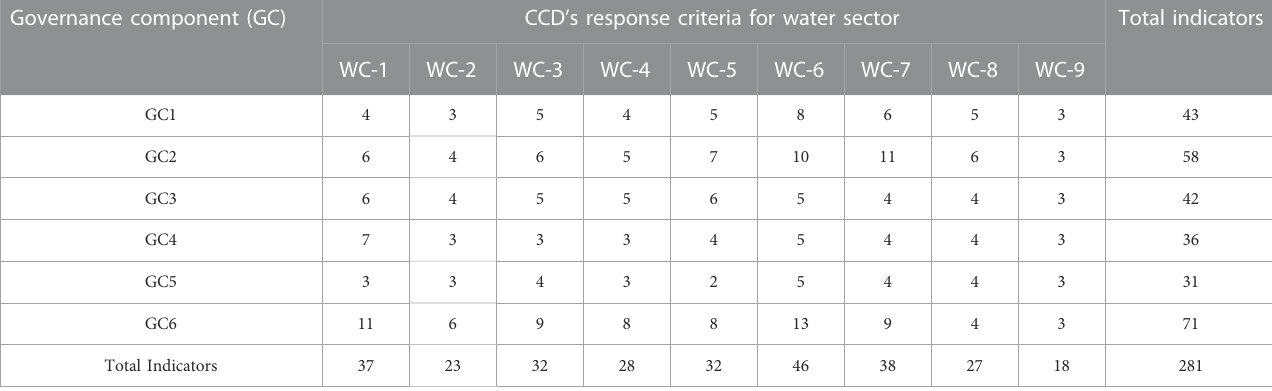
TABLE 2 Composite Indicators based on governance component and CCD criteria [Source: (Iqbal, 2021)]. Governance component